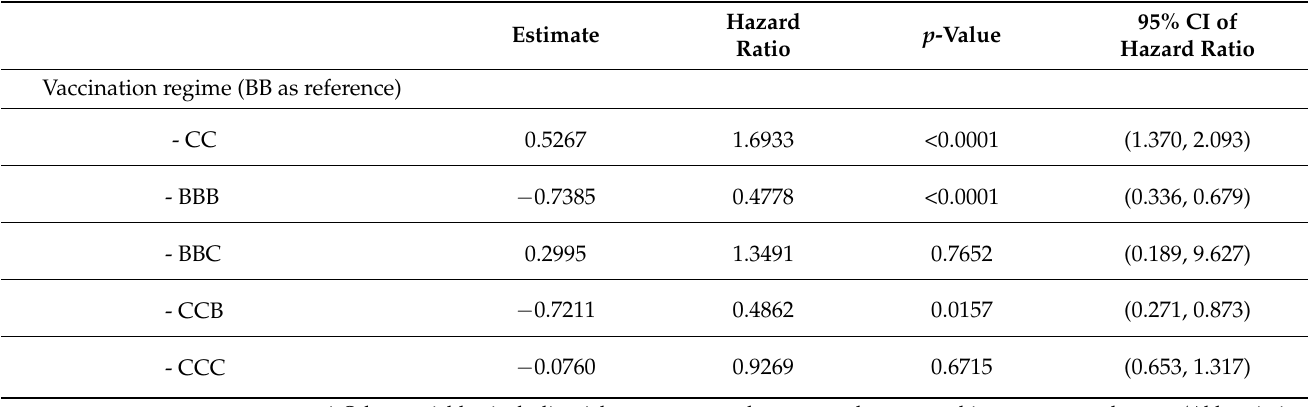
vaccination regime *. Table 6. Time-dependent Cox regression analysis on risk of acquiring COVID-19 with different vac-